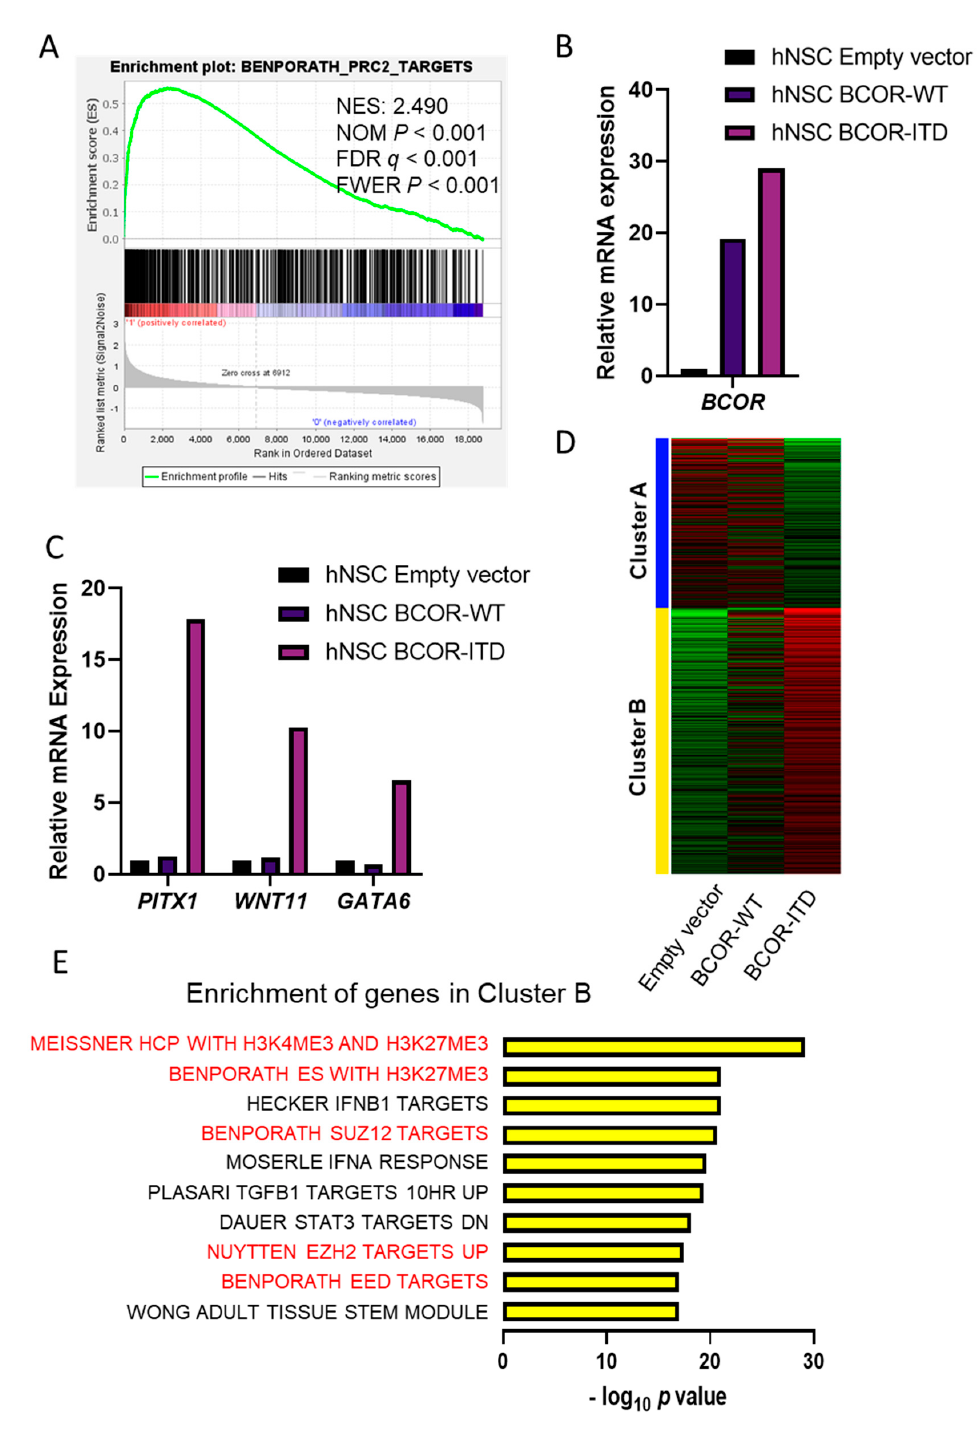
Figure 2. BCOR-ITD is associated with upregulation of PRC2 targets in primary tumors and neural stem cells. ( A ) GSEA of CNS-BCOR ITD primary tumors revealed significant upregulation of PRC2 targets. ( B ) Increased expression of BCOR mRNA in BCOR-WT and BCOR-ITD hNSC models. ( C ) Increased mRNA expression of PRC2-target genes PITX1, WNT11, and GATA6 in hNSC with BCOR-ITD determined by RTqPCR. ( D ) K-means clustering identified two clusters of differentially expressed genes between hNSC with empty vector, BCOR-WT, and BCOR-ITD. ( E ) Top 10 gene sets from MsigDB c2 enriched in Cluster B, with PRC2 or H3K27me3 related gene sets highlighted in red.